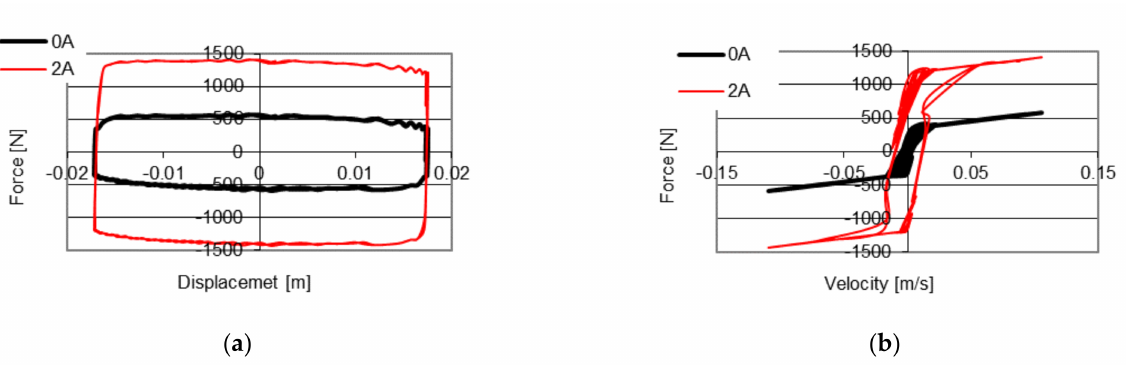
Figure 4. Results of numerical research on the MR damper model, ( a ) plane: force–displacement, ( b ) plane: